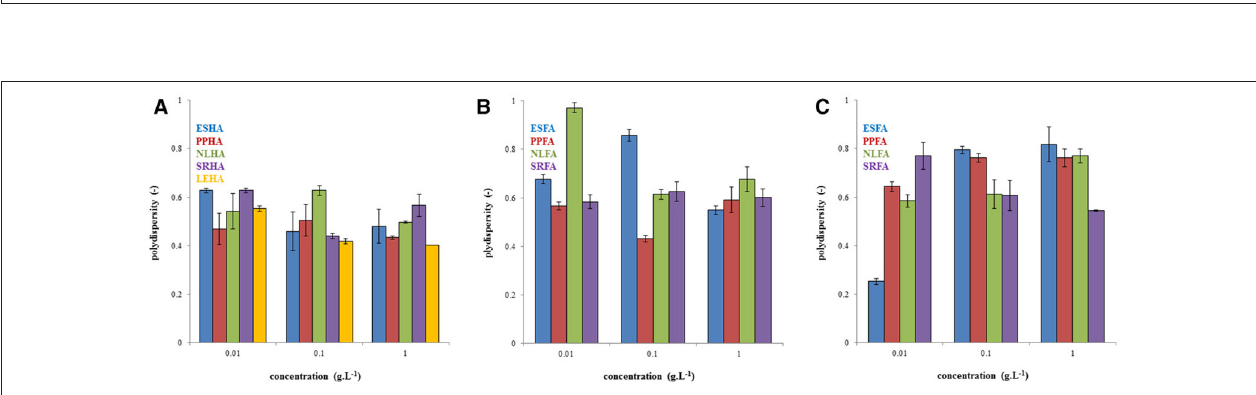
FIGURE 2 | Polydispersity of humic acids dissolved in 0.01M NaOH (A) , fulvic acids dissolved in 0.01M NaOH (B) , and fulvic acids dissolved in water (C) .